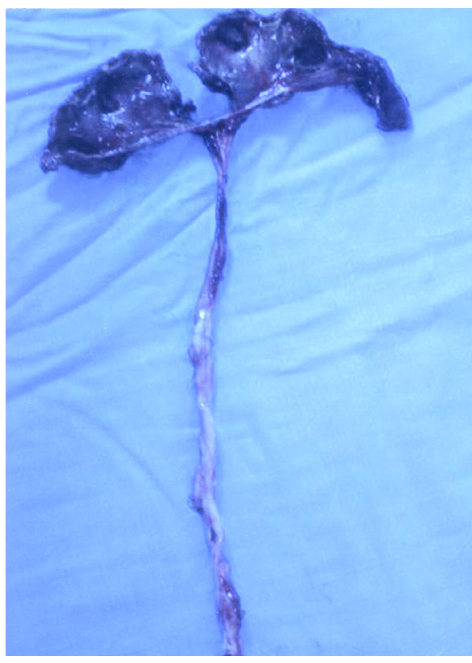
Figure 1 – Incised upper pole. Note the exteriorized catheter through ureteropelvic junction.